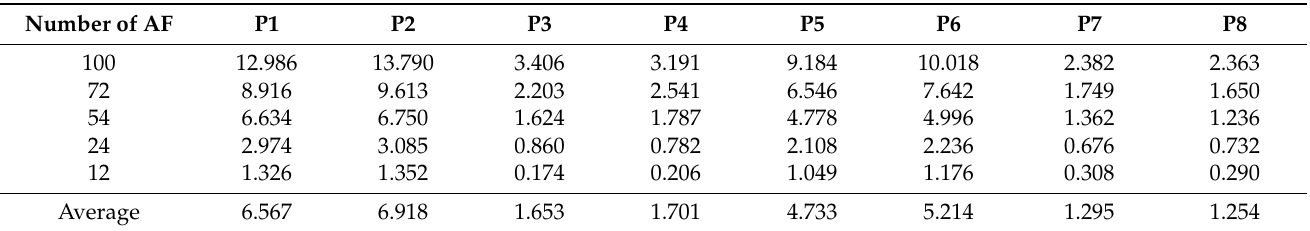
Table 6. Average positioning time of random deployment in target